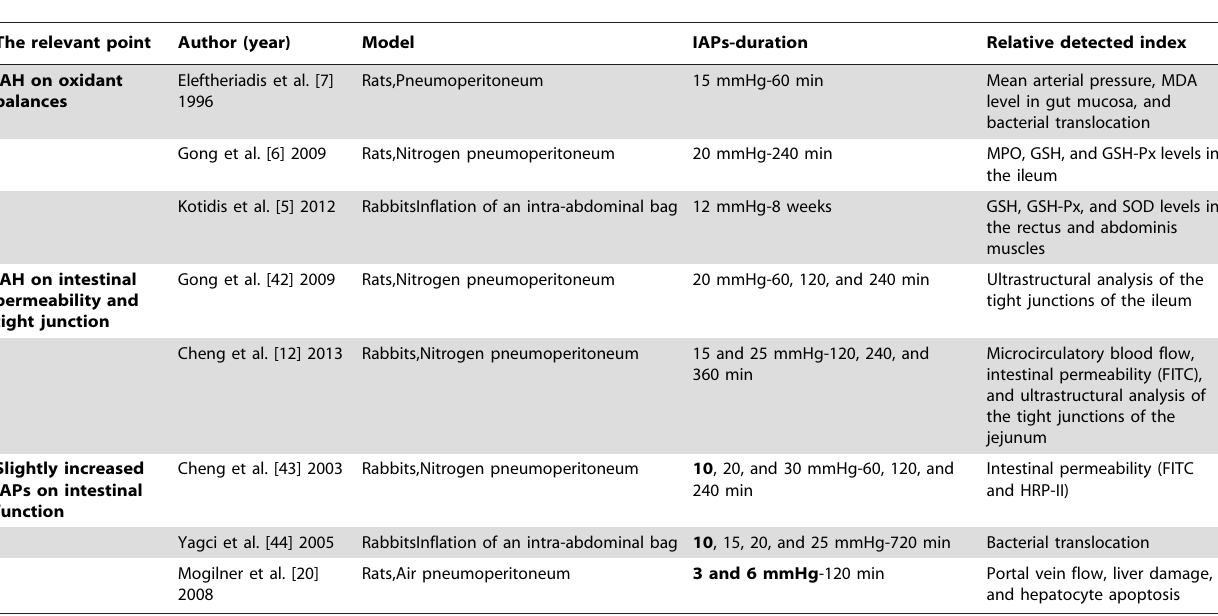
Table 3. Literature overview of the currently published animal experiments related to the present study.